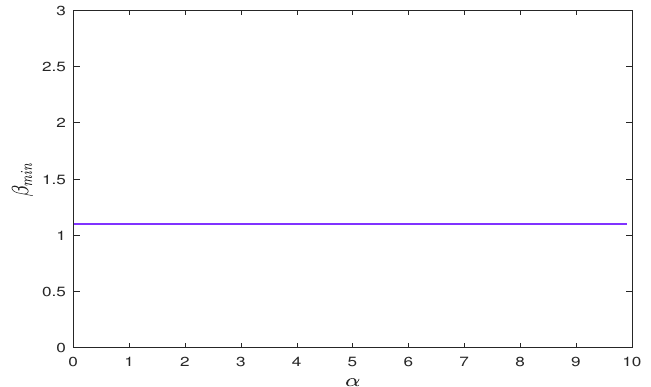
Figure 8. Curve of ϕ vs. ψ min for SFC case.